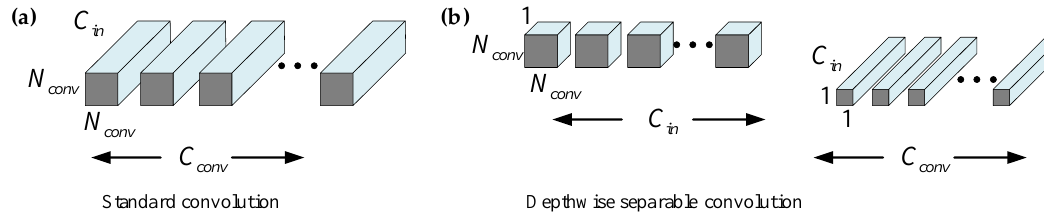
Figure 21. Comparison of standard convolution and depthwise separable convolution. ( a ) Standard convolution; ( b ) depthwise separable convolution.